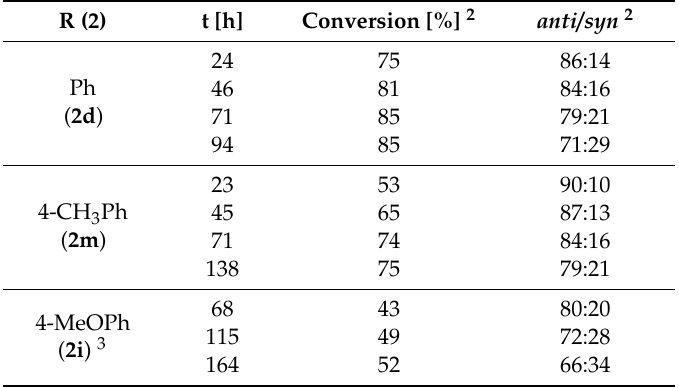
Table 7. Study of the reaction outcome as a function of the reaction time 1